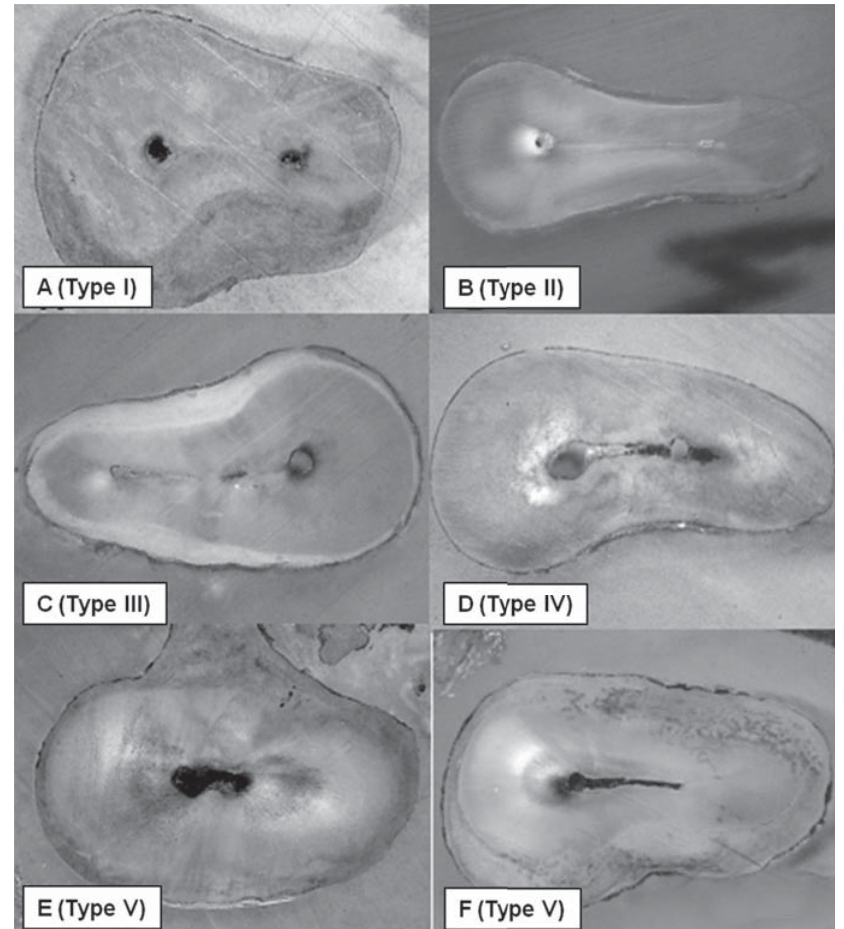
Figure 1- (cid:2)&(cid:18)(cid:8)(cid:26)(cid:21)(cid:14)(cid:18)H(cid:2)(cid:21)(cid:12)(cid:5)(cid:19)(cid:26)(cid:12)(cid:17)(cid:12)(cid:10)(cid:15)(cid:6)(cid:2)(cid:8)(cid:24)(cid:19)(cid:4)(cid:18)(cid:2)(cid:15)(cid:7)(cid:2)(cid:21)(cid:4)(cid:18)(cid:15)(cid:9)(cid:17)J>(cid:14)(cid:6)(cid:6)(cid:9)(cid:17)(cid:2)(cid:5)(cid:12)(cid:12)(cid:8)(cid:18)(cid:2)(cid:12)(cid:16)(cid:2)(cid:14)(cid:19)(cid:19)(cid:4)(cid:5)(cid:2)(cid:13)(cid:5)(cid:18)(cid:8)(cid:2)(cid:21)(cid:12)(cid:17)(cid:9)(cid:5)(cid:29)(cid:2)(cid:22)(cid:5)(cid:12)(cid:21)(cid:2)K(cid:2)(cid:8)(cid:12)(cid:2)Q+(cid:2)(cid:8)(cid:24)(cid:19)(cid:4)(cid:18)(cid:2)&(cid:2)(cid:8)(cid:12)(cid:2)&WX(cid:2)Y(cid:2)(cid:9)(cid:7)(cid:11)(cid:2)(cid:22)(cid:2)(cid:9)(cid:5)(cid:4)(cid:2) type